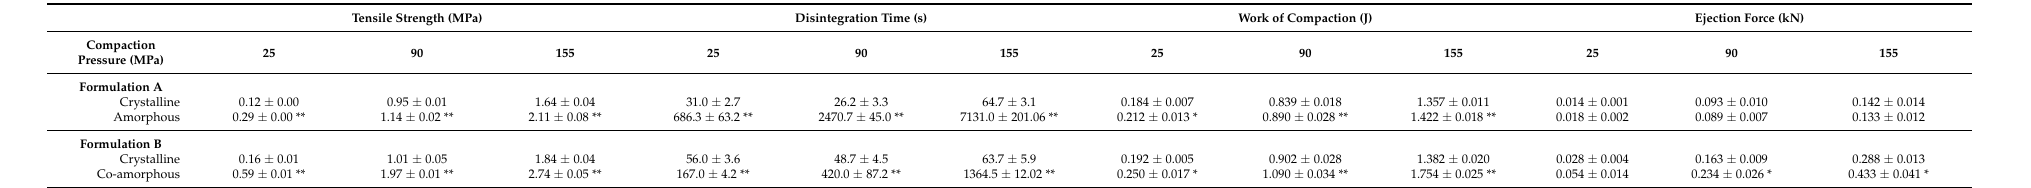
Table 4. Properties of tablets (tensile strength, disintegration time, work of compaction, and ejection force) produced under different compaction pressures (considering both crystalline and (co-)amorphous OLZ incorporated in formulations A and